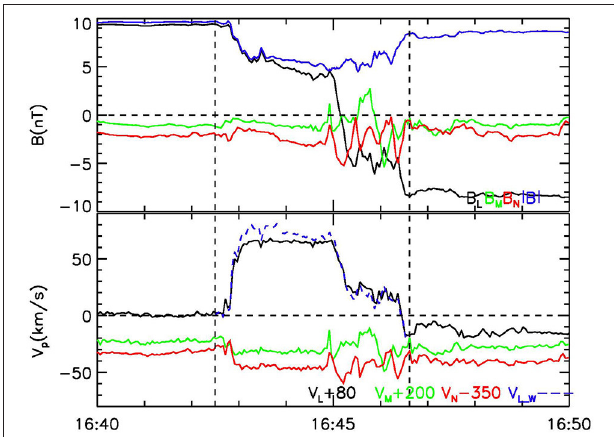
FIGURE 5 | The reconnection exhaust around 16:45 UT November 16th measured by Wind. The format of the figure is same as Figure 3